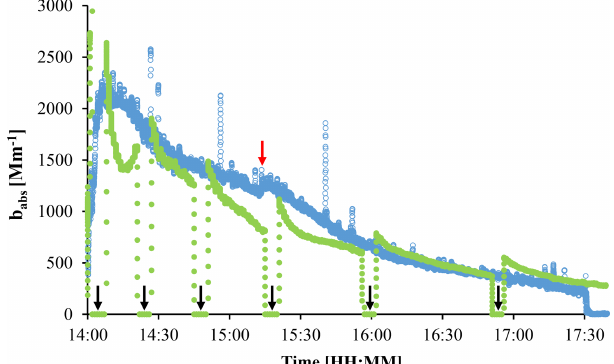
Figure 12. Comparison of measured light absorption for the MSPTI (blue) and AE33 (green) sampling from a common pre-prepared aerosol reservoir filled with graphitic soot prepared with an elec- trical discharge source. Data points represent a 9s running average of 1s data. Black arrows indicate automated filter changes for the AE33, and the red arrow indicates a suspected mode hop by the MSPTI